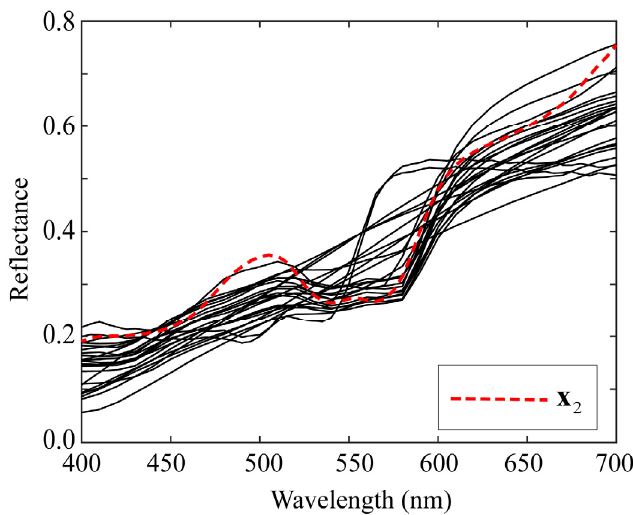
Figure 10. Spectral curves of 23 local optimal reflectances used for estimating second spectral reflectance x 2 in 24 color checkers.